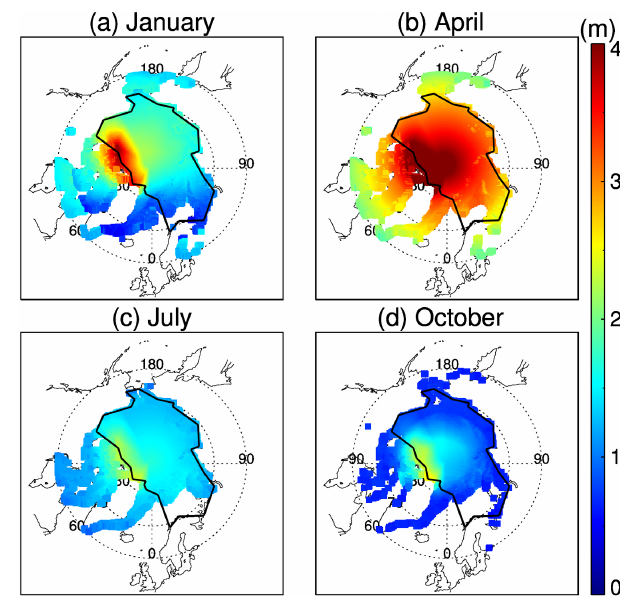
Figure A3. Derived climatological mean sea ice thickness distribu- tion in the Arctic from OTIM, 1984 to